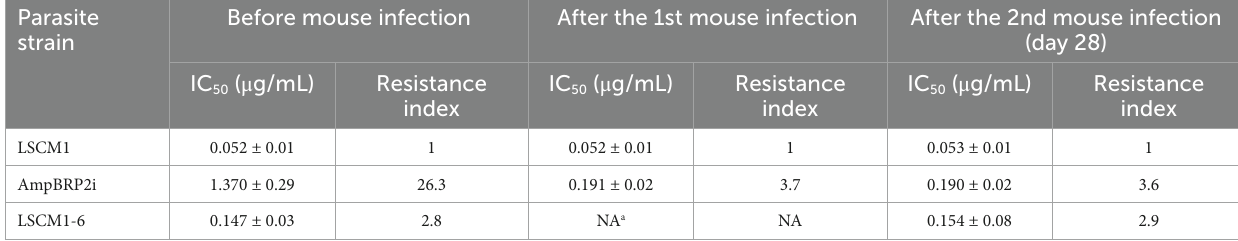
TABLE 2 Promastigote susceptibility to AmpB for the LSCM1, AmpBRP2i, and LSCM1-6 strains before and after mouse infection. Results are expressed as mean ± SD based on three independent replicates. Parasite